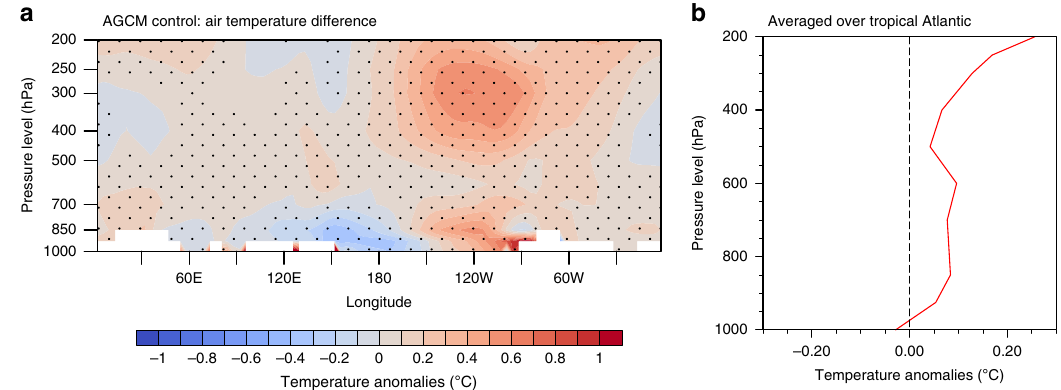
Fig. 3 Air temperature mean state change related to the Paci fi c bias. a Tropical (15°S – 15°N) air temperature climatology difference between the Paci fi c bias and the unbiased simulations in the atmosphere-only (AGCM) control runs. Stippling indicates the statistical signi fi cance at the 90% con fi dence level for air temperature differences. b Atlantic region (60°W-0) averaged air temperature difference pro fi